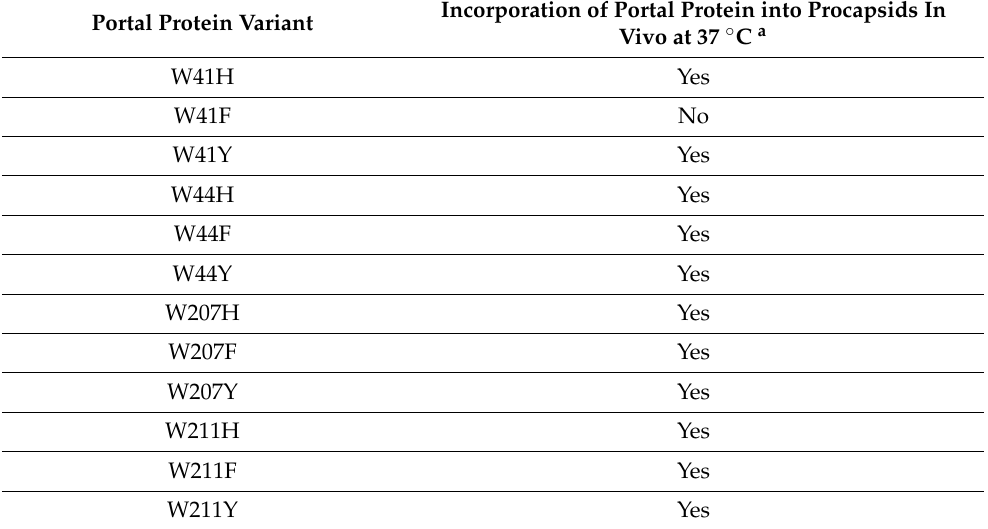
Table 2. In vivo incorporation of trp to his, phe and tyr portal protein variants into procapsids. Incorporation of Portal Protein into Procapsids Portal Protein Variant